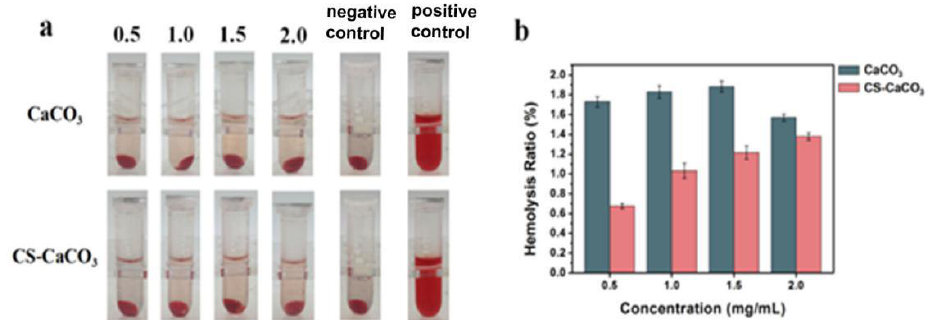
Figure 7. ( a ) Images of RBCs incubated with CaCO 3 and CS – CaCO 3 at 37 °C for 1 h; ( b ) Hemolysis assay for CaCO 3 and CS – CaCO 3 .